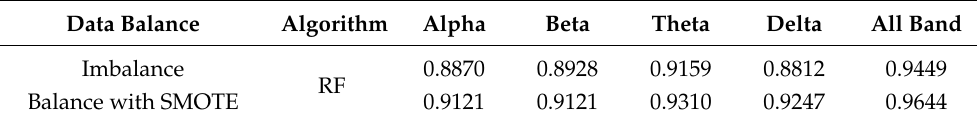
Table 8. Overall accuracy values are based on the features of different